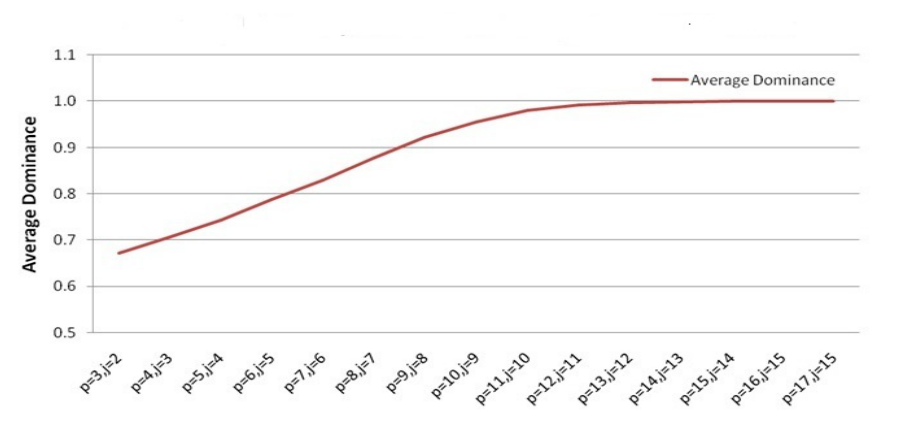
Figure 3: Average dominance condition for given value of p & j for